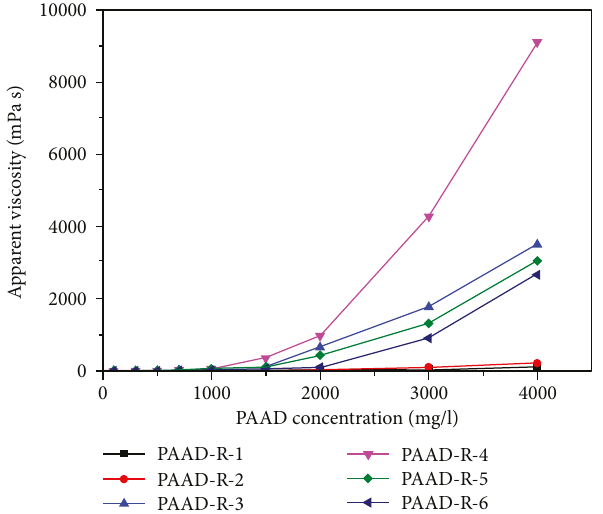
O and solid-state 13 C NMR of PAAD at 25 ° C: (a) DPA and (b) PAAD. 2